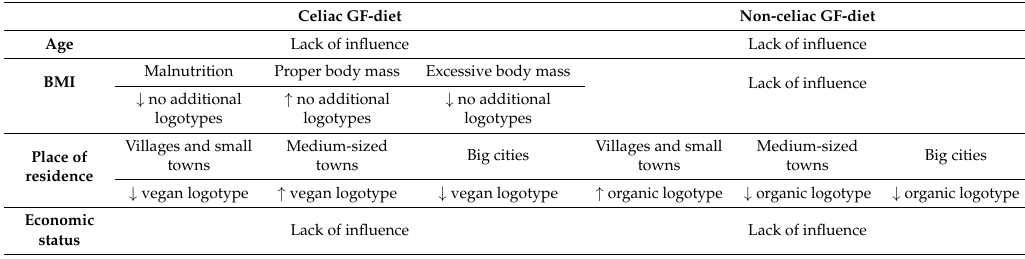
Table 10. The summary of the obtained results of the front-of-package “gluten-free” (GF) product labeled attributes influencing the choice of GF bread in subgroups of celiac GF-diet and non-celiac GF-diet